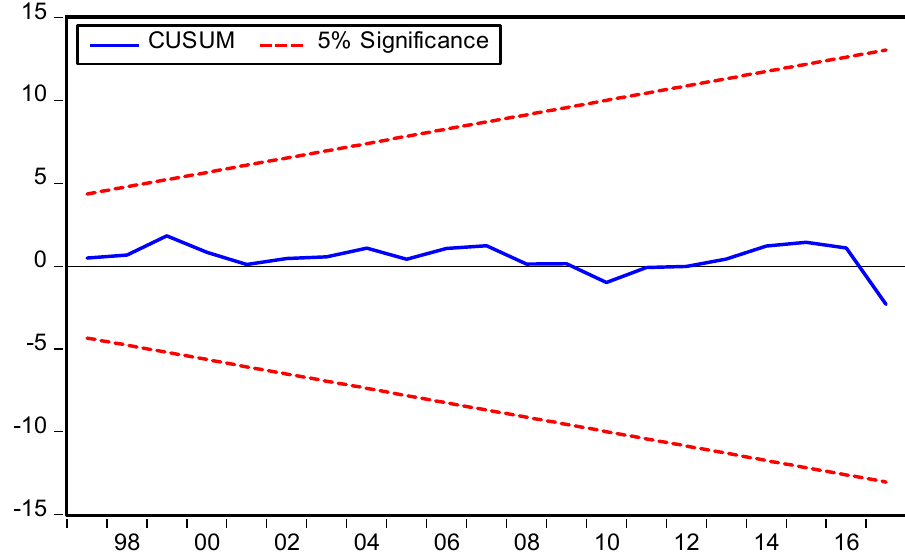
Int. J. Environ. Res. Public Health 2022 , 19 , x FOR PEER REVIEW Figure 3. Symmetric ARDL CUSUM test. Figure 3. Symmetric ARDL CUSUM test.